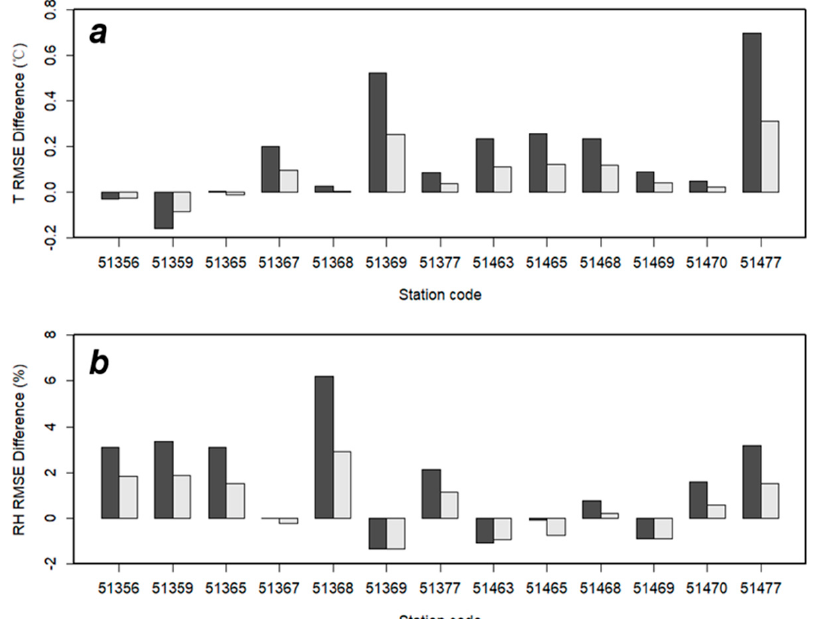
Figure 11. Difference between the RMSE values of post-correction forecasts for: ( a ) temperature and ( b ) relative humidity by AutoML model and multiple linear regression MOS method compared to single linear regression method. The deep gray bar and light gray bar indicate raw forecasts and post-processed forecasts.